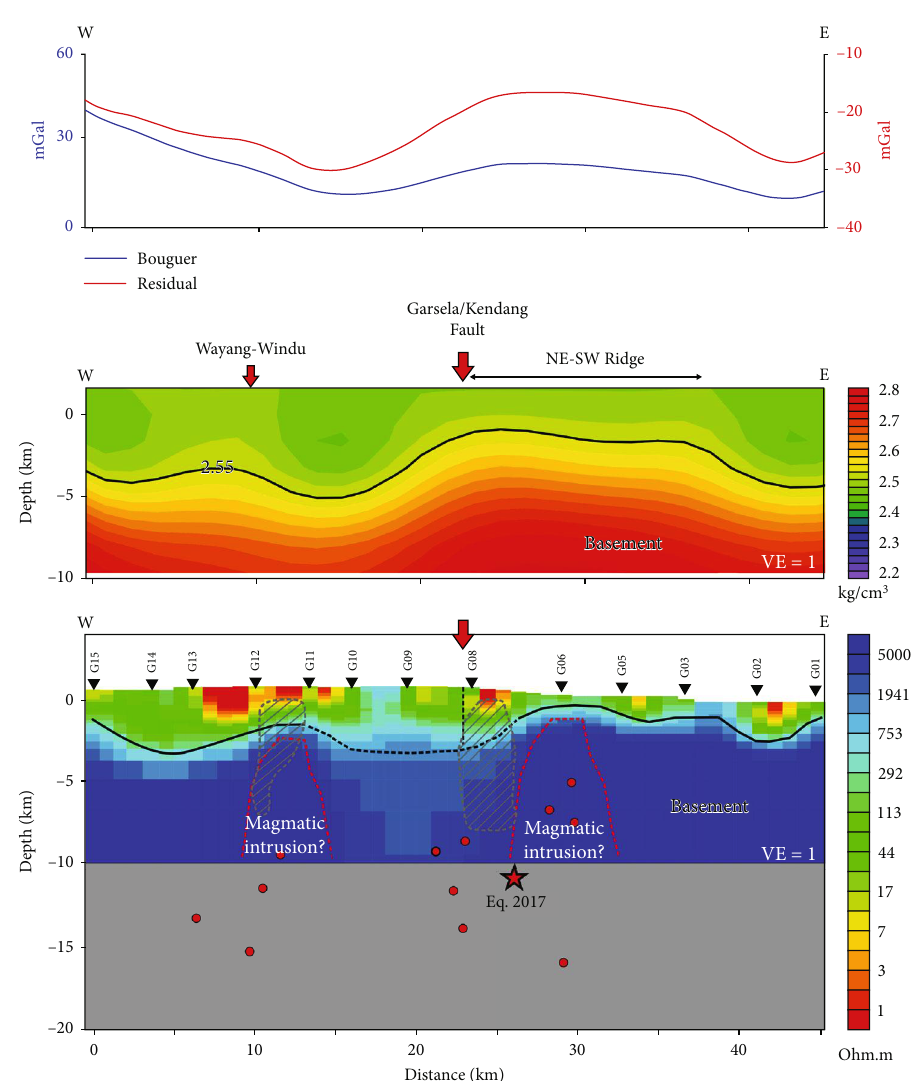
Figure 15: Interpretation of the density (top) and resistivity (bottom) models of line D-D ′ . Undulating basement corresponds to the microearthquake (MEQ) clusters (grey shaded area) in Wayang-Windu and Darajat